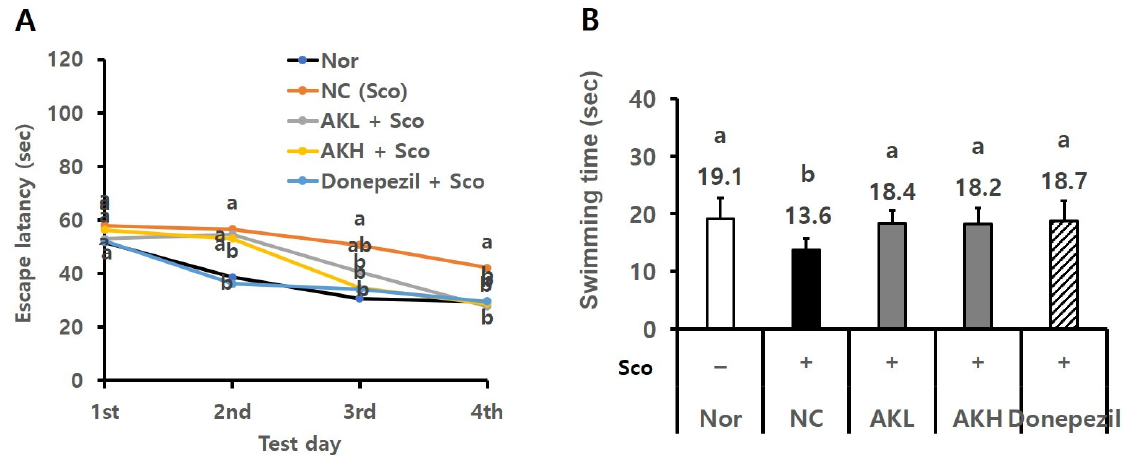
Figure 9. Effects of AK extract on behaviour in the Morris water maze test on acutely scopolamine-treated mice. ( A ) Escape latency in the acquisition phase, and ( B ) swimming time in the target quadrant in the probe trial. Mice were orally administered AK extract 112.7 mg/kg (low dose; AKL) or AK extract 328.0 mg/kg (high dose; AKH) for 21 days; after 30 min, they were intraperitoneally injected with scopolamine (1 mg/kg/day) for test days. Nor: normal, vehicle-treated; NC: negative control, scopolamine; Donepezil: Donepezil 1 mg/kg in saline + scopolamine ( n = 10). Statistical analysis was performed using SAS software. The values indicated with different letters were observed to differ significantly at p < 0.05 by Duncan’s multiple range test.